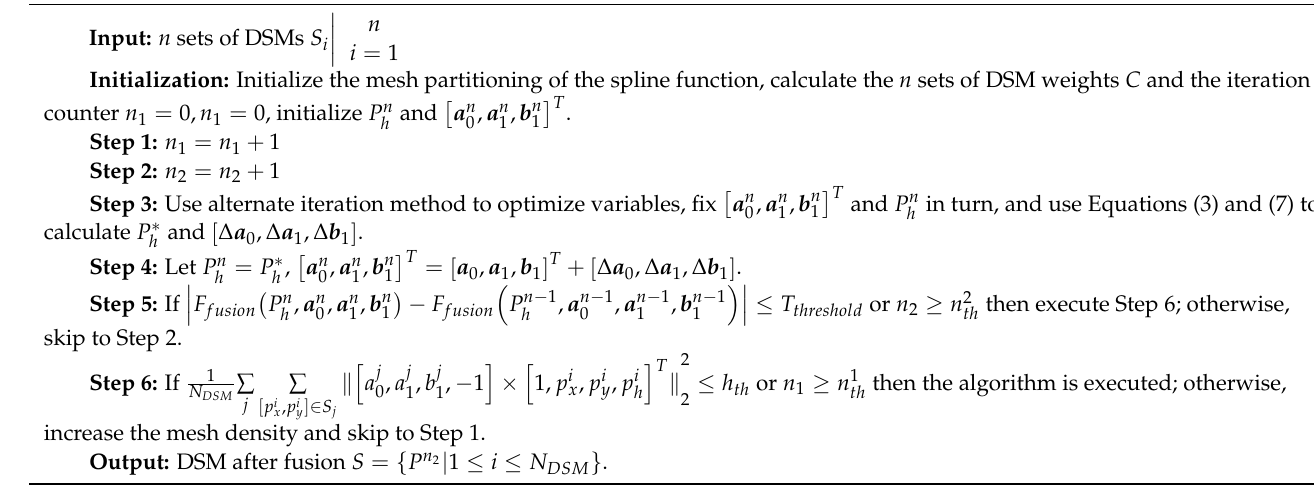
Algorithm 1. DSM fusion method based on adaptive spline guided by building target structure